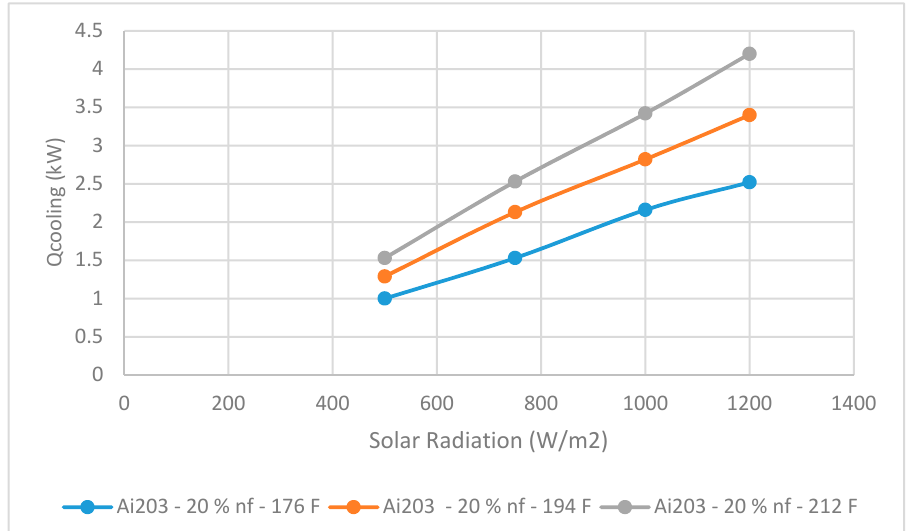
Figure 14. Cooling load effect produced with AI 2 O 3 at different temperatures.